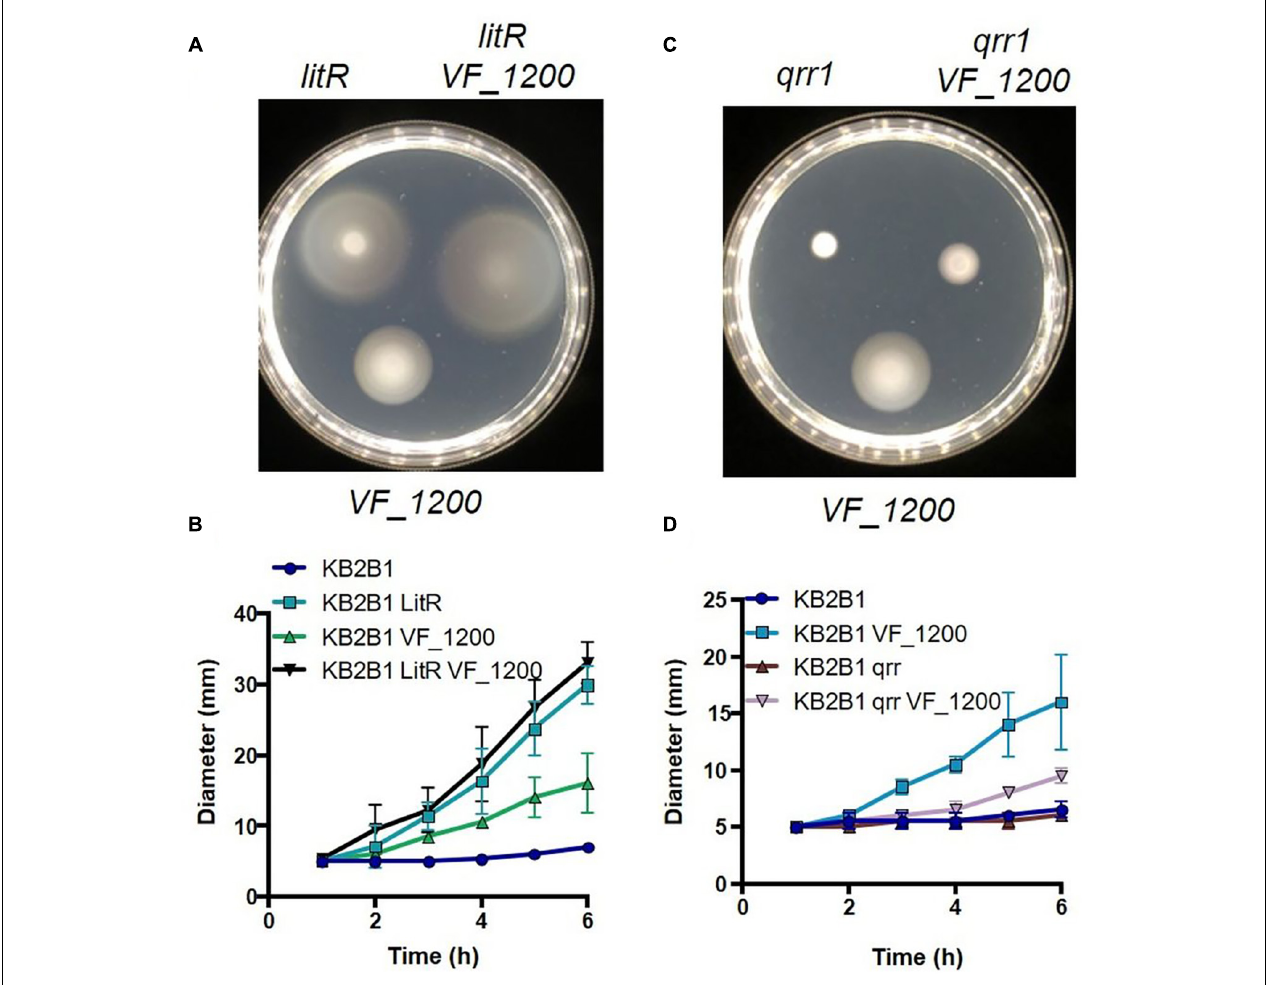
FIGURE 10 | Epistasis of quorum sensing and VF_1200 pathways. Migration on TBS-Mg 2 + soft agar of KB2B1 and derivatives (A) KV9023 ( litR ), KV8973 ( (cid:49) VF_1200 ), and KV9067 ( litR (cid:49) VF1200 ); (B) KV9105 ( (cid:49) qrr1 ), KV8973 ( (cid:49) VF_1200 ), and KV9115 ( (cid:49) qrr1 (cid:49) VF_1200 ). (A,C) Images were captured at 6 h. (B,D) Measurements of the migration on TBS-Mg 2 + agar of the strains shown in panels (A,C)